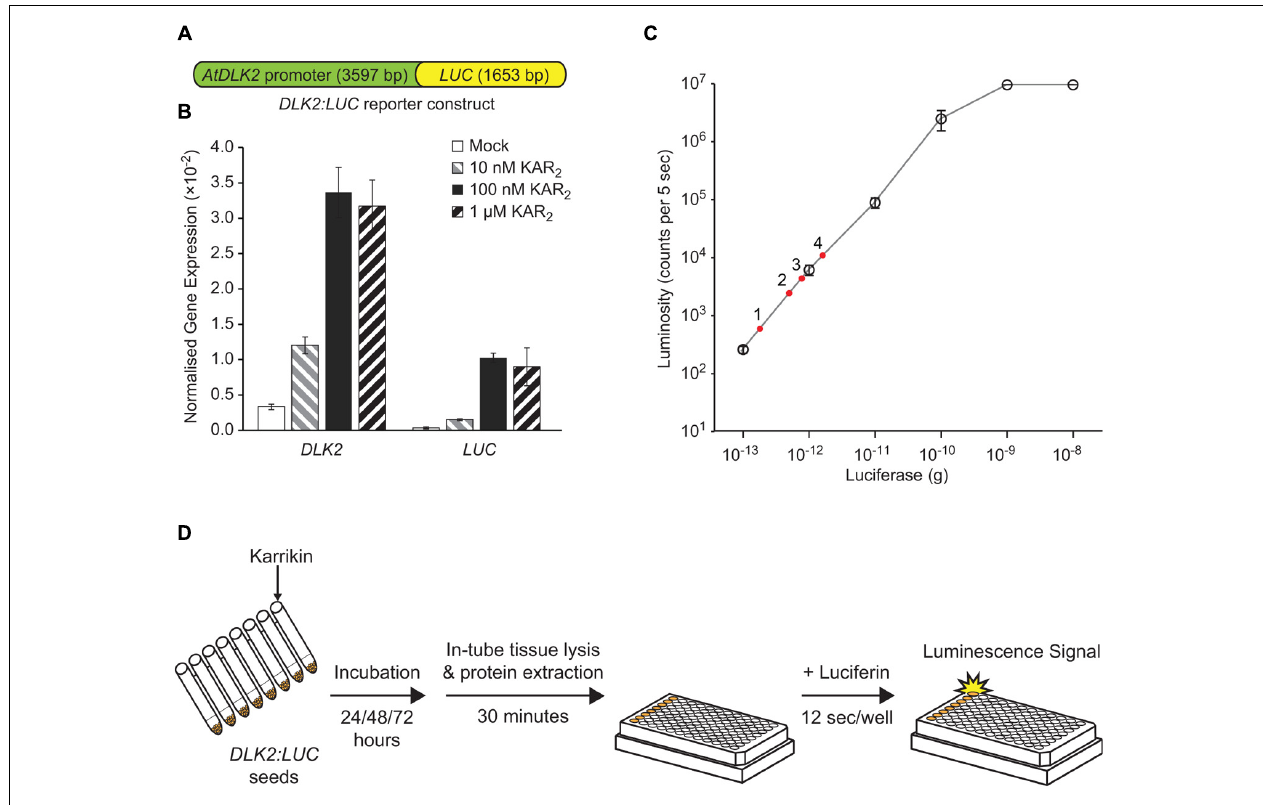
FIGURE 1 | Development of the DLK2:LUC reporter assay. (A) Schematic representation of the DLK2:LUC reporter construct that was transformed to Arabidopsis wild-type L er ( DLK2:LUC [L er ]) and crossed into the karrikin insensitive 2-2 ( kai2-2) mutant background ( DLK2:LUC [ kai2 ]). The construct contains 3566 bp of intergenic sequence upstream of the transcriptional start site of D14-LIKE 2 ( DLK2, At3g24420), 31 bp of DLK2 5 (cid:48) UTR, and 1653 bp of FIREFLY LUCIFERASE ( LUC ) coding sequence. (B) Response of DLK2 and LUC transcripts to karrikin treatments in DLK2:LUC reporter seeds. Transcript abundance was normalized to CACS (At5g46630). Error bars show standard errors (SE) with n = 3 batches of seeds. In this assay, neither DLK2 nor LUC transcripts could be detected reliably in the DLK2:LUC [ kai2 ] reporter seeds. (C) Standard curve of firefly luciferase enzymatic activity using purified firefly luciferase enzyme and D -luciferin substrate. Error bars show SE with n = 3 experimental replicates, where each dilution was measured with three technical replicates. The red dots represent a typical dataset where luciferase activity in DLK2:LUC [L er ] is induced by (1) mock; (2) 10 nM KAR 2 ; (3) 100 nM KAR 2 ; (4) 1 µ M KAR 2 over 72 h. (D) Illustration of the DLK2:LUC assay procedure (illustration of the 96-well plate is adapted from Promega’s Technical Bulletin – Luciferase Assay System